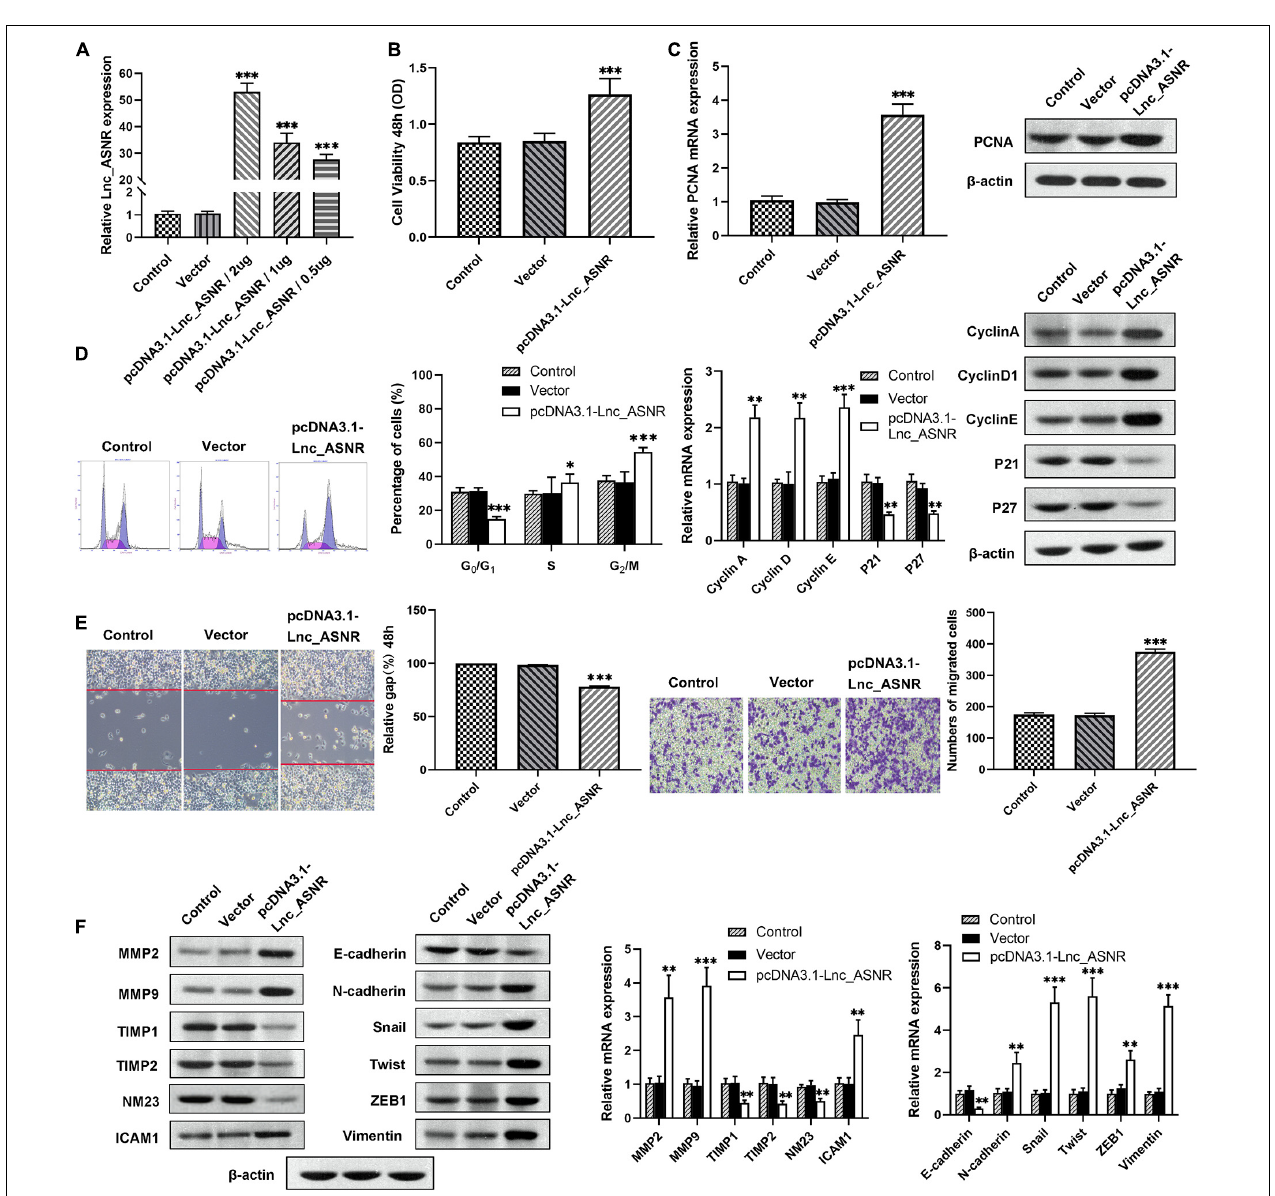
FIGURE 3 | Lnc_ASNR overexpression promotes GC cell proliferation, migration, and invasion. (A) qPCR detected overexpress efficiency of pcDNA3.1-Lnc_ASNR. (B) MTT assays examined the cell viability of MKN28 cells after treatment with pcDNA3.1-Lnc_ASNR or vector. (C) PCNA mRNA and protein level in pcDNA3.1-Lnc_ASNR-transfected MKN28 cells were evaluated by carrying out qPCR and western blot assays. (D) Cell cycle was verified by using flow cytometry in MKN28 cell lines and cycle-related mRNA and protein level were evaluated by qPCR and western blot assays. (E) The migration ability with Lnc_ASNR-overexpressed MKN28 cells was detected by wound-healing assay. The invasion ability was detected by invasion assay with Lnc_ASNR-overexpressed MKN28 cells. (F) The expression of metastasis-related mRNA and proteins with Lnc_ASNR overexpressed MKN28 cells were investigated by performing qPCR and western blot assays. Error bars, mean ± SEM. * P < 0.05; ** P < 0.01; *** P <